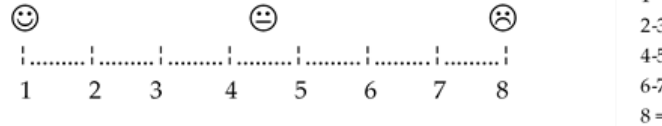
Figure 1. Likert-type scale with 5 score ranges. Stress Scale.